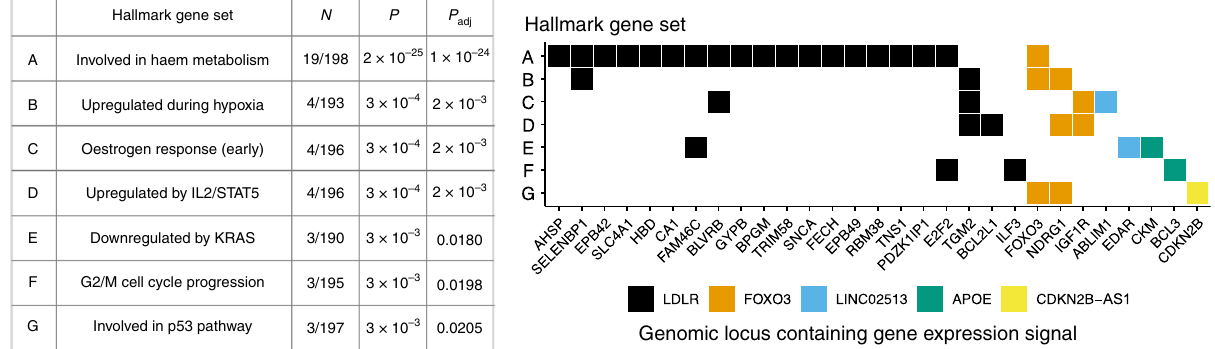
Fig. 3 Seven hallmark gene pathways are enriched for ageing-related genes. N number of genes of interest vs. total number of genes in the gene set for which eQTL are available. P Nominal P value of the hypergeometric test for enrichment (against 24,670 background genes). P bonf Bonferroni-corrected P value for testing seven hallmark pathways (containing at least three genes). The fi gure shows individual genes on the x -axis and hallmark pathways are listed on the y -axis, matching the order of the table. Squares represent the presence of a gene in the gene set.